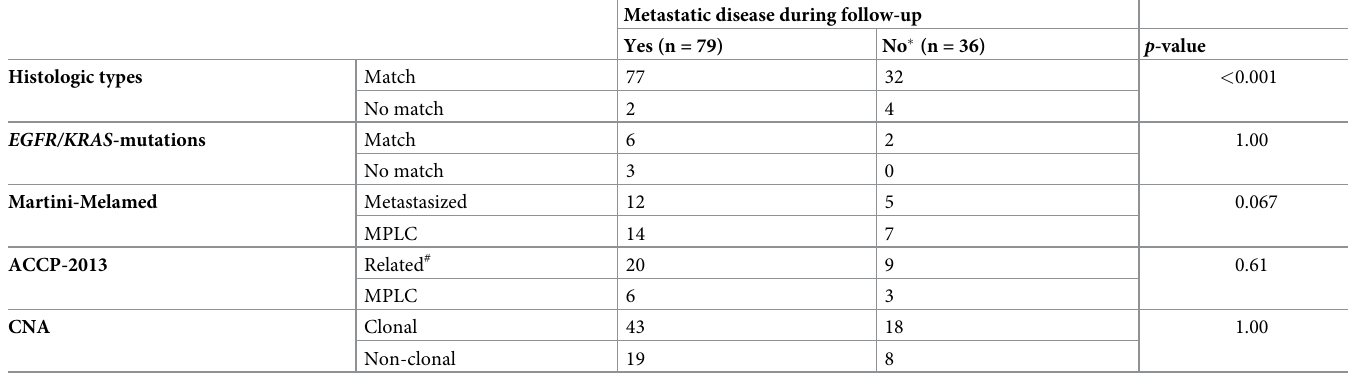
Table 6. Follow-up data categorized by method for clonality